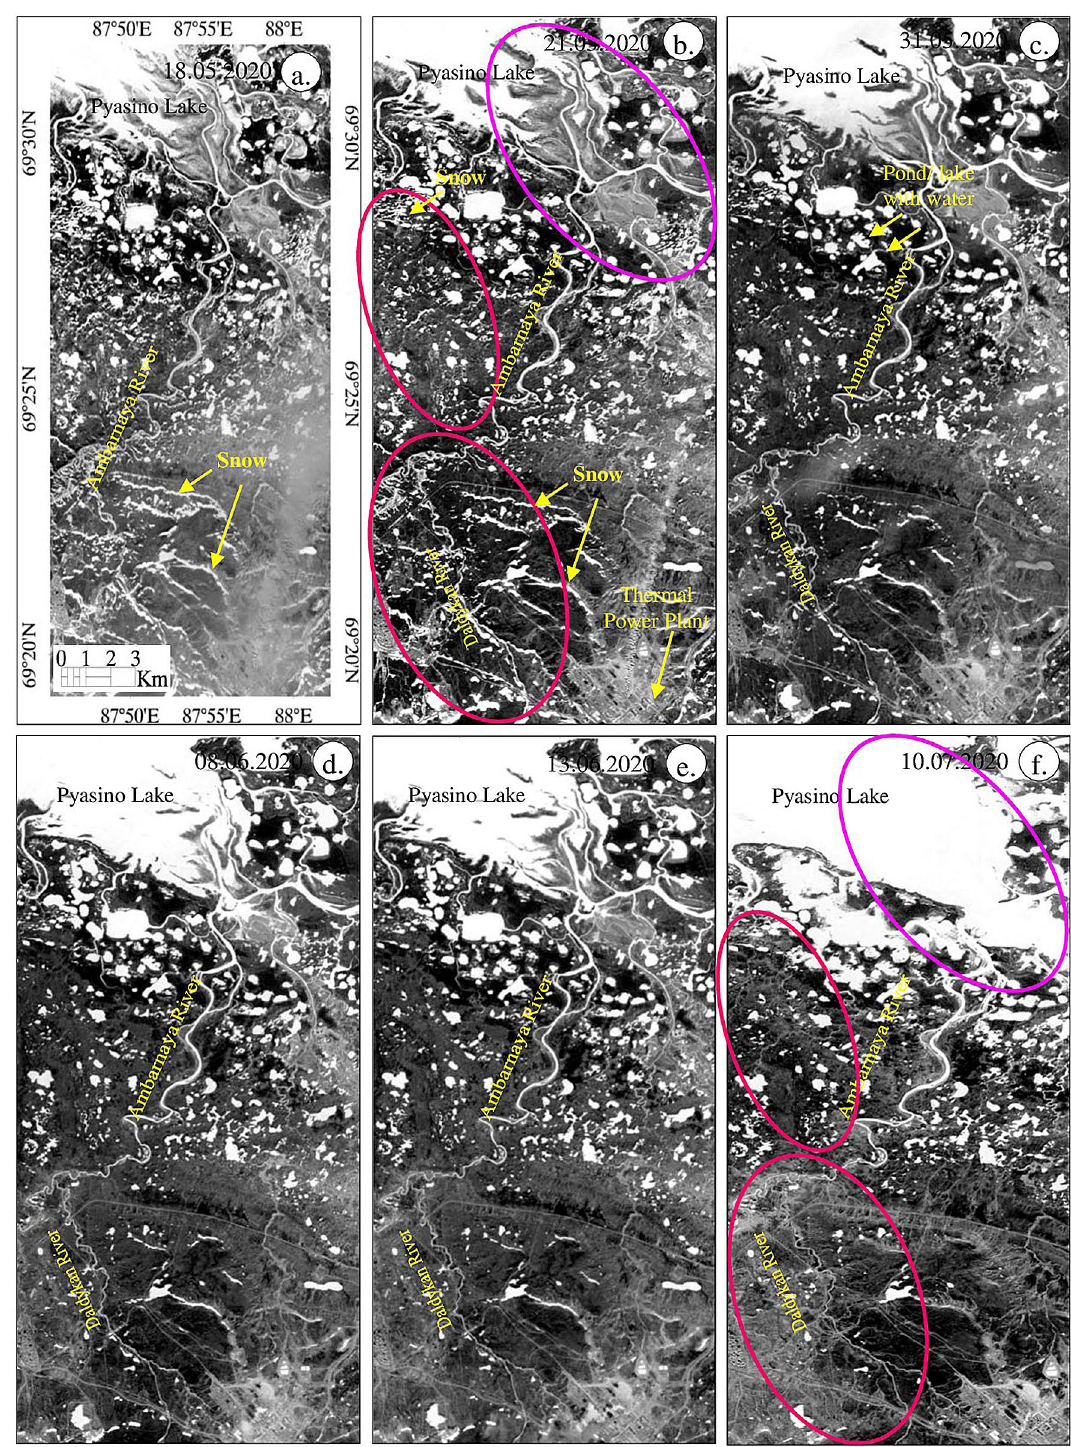
Figure 6. ( a – f ) Sentinel-2 SWI images of May 18 to July 10, 2020 [ENVI 5.5 https ://www.harri sgeos patia l.com; https ://senti nel.esa.int/] showing the existence of snow and ice, and water resources of the study area in bright